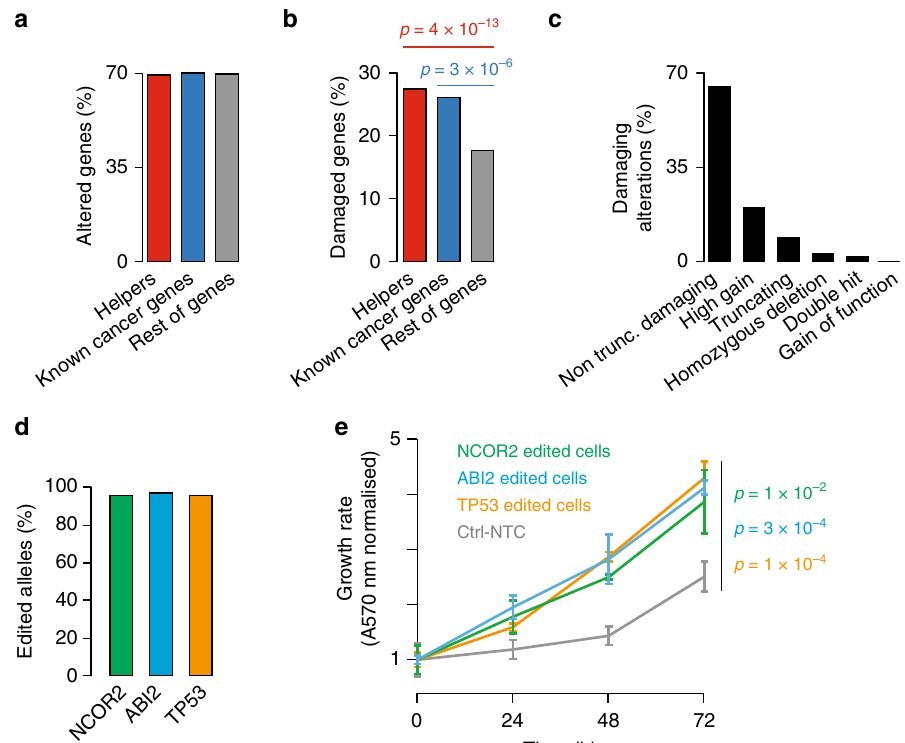
Fig. 7 Effect of helper alterations in Barrett ’ s esophagus cells. a Percentages of altered helper genes (661/952), known cancer genes (364/518) and rest of cancer unrelated genes (12,250/17,544) over the corresponding total. b Percentages of damaged helper genes (261/952), known cancer genes (135/518) and rest of cancer unrelated genes (3,093/17,544) over the corresponding total. Statistical signi fi cance was assessed with two-tailed Fisher ’ s exact